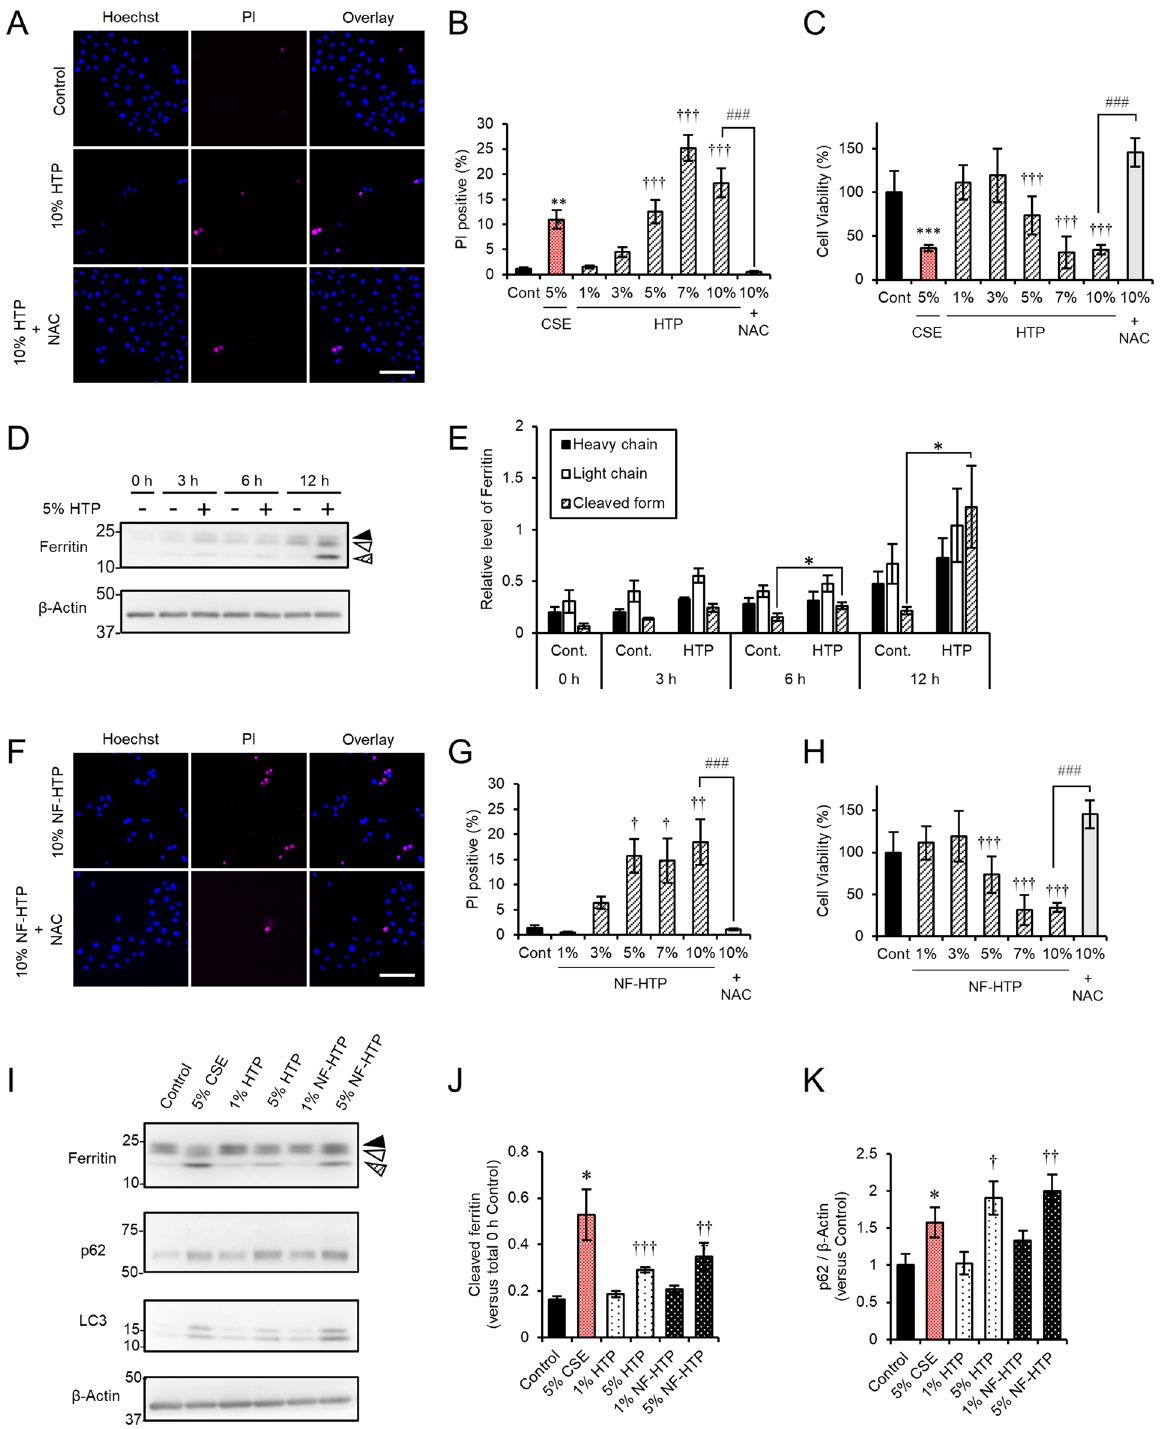
Figure 5. Exposure of HCE-T cells to HTPs induced cell death and accelerated ferritin cleavage. ( A ) Representative images of PI (magenta) and Hoechst 33342 (blue) staining after exposure to HTPs in the presence or absence of 1 mM NAC. ( B ) The bars show the PI-positive cell ratios. ( C ) Cell viability was measured with a CCK-8 assay. ( D ) Immunoblotting of HCE-T cell extracts exposed to HTPs. ( E ) Quantitation of the fold increase of each form of ferritin (heavy chain, black arrowheads; light chain, white arrowheads; cleaved form, arrowheads filled with diagonal lines) after exposure to HTPs. ( F ) Representative images of PI (magenta) and Hoechst 33342 (blue) staining after exposure to nicotine-free HTPs (NF-HTPs). ( G ) The bars show the PI-positive cell ratios. ( H ) Cell viability was measured with a CCK-8 assay. ( I – K ) Immunoblotting of extracts derived from HCE-T cells incubated without (control) or with either CSE (5%), HTPs (1 or 5%), or NF-HTPs (1 or 5%) for 24 h was conducted using the indicated antibodies. ( J , K ) show the cleaved form of ferritin and p62 (both normalized to β-actin), respectively. Bars = 100 µm ( A , F ). The data are represented as the mean ± SEM (n = 6). * P < 0.05, ** P < 0.005, *** P < 0.001, Student’s t -test vs. Control (Cont); † P < 0.05, †† P < 0.005, ††† P < 0.001, Dunnett’s test vs. Control (Cont); ### P < 0.001, Student’s t -test vs. 10% HTPs or